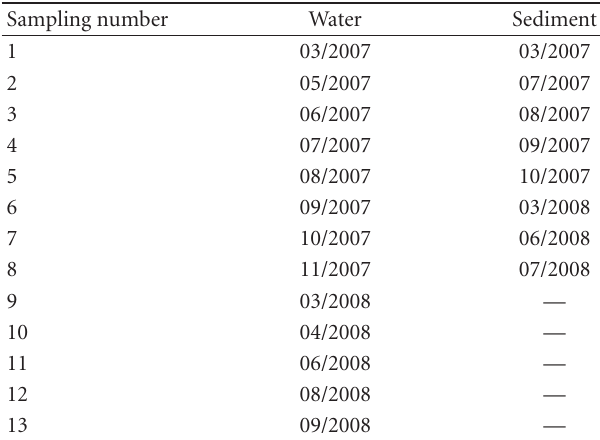
Table 1: Dates (month/year) of the water and sediment sampling